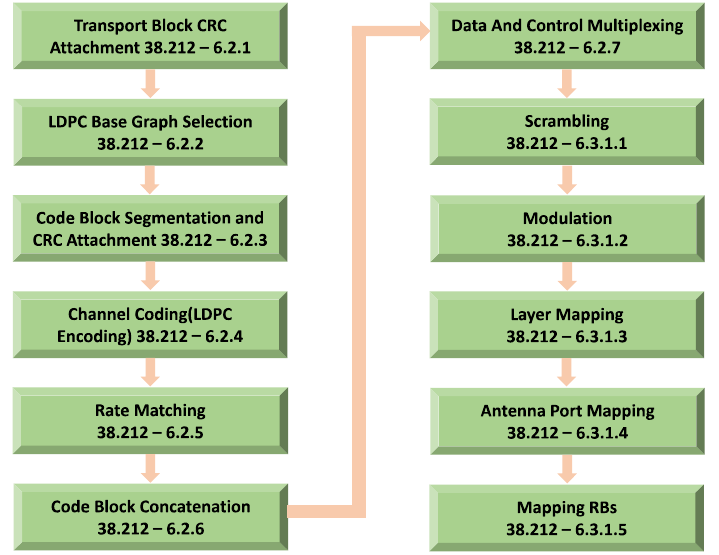
Figure 4. 5G physical layer